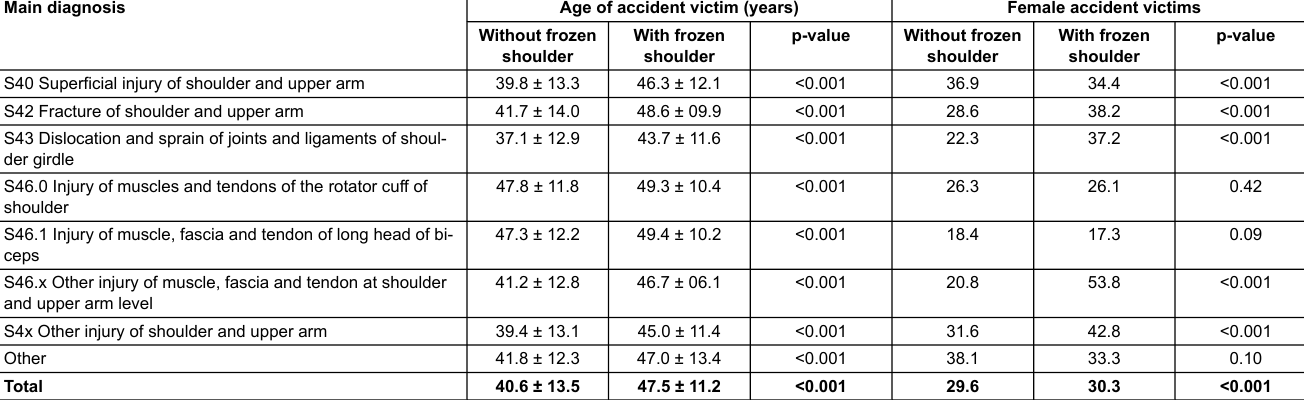
Table 2: Age and gender of accident victims for cases with shoulder injuries as main diagnosis. For age, mean values and standard deviation are given with p-values from t- tests. For gender, percentage of female accident victims in the subgroups are indicated with p-values from chi 2 -tests. Main diagnosis